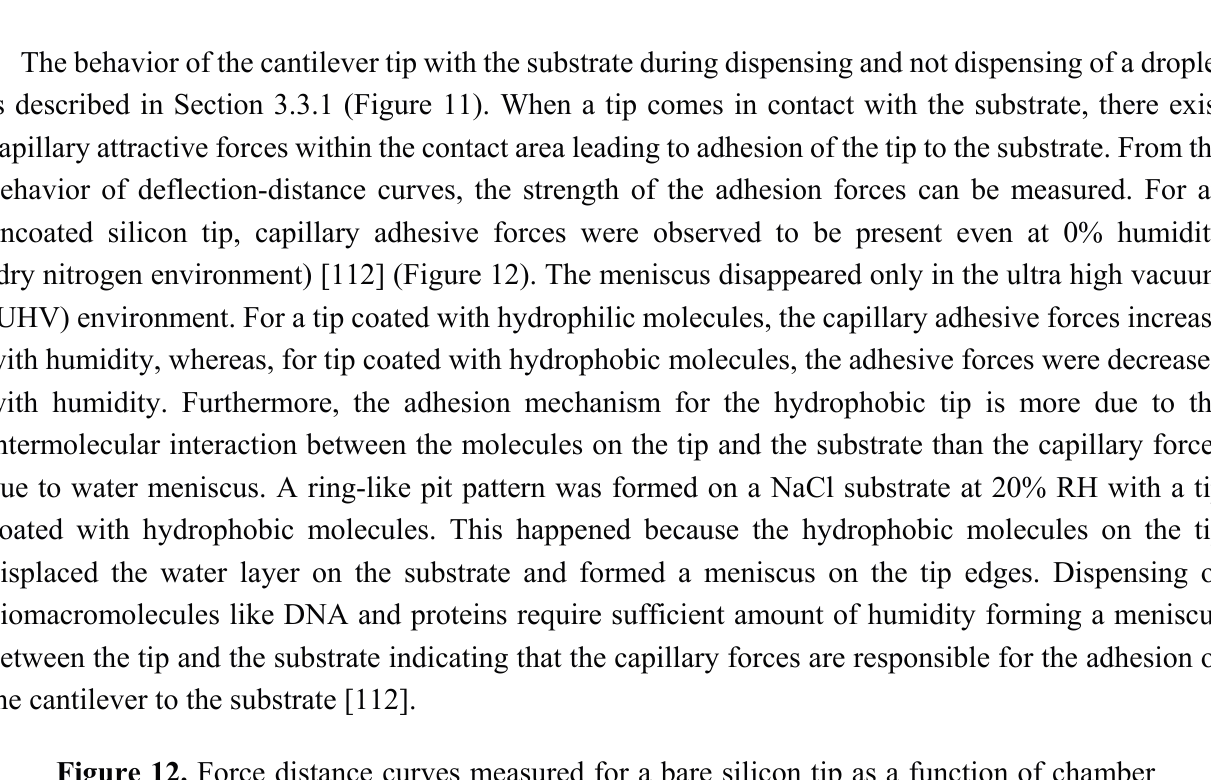
Figure 12. Force distance curves measured for a bare silicon tip as a function of chamber humidity content varying from 22% relative humidity (RH) to ultra high vacuum